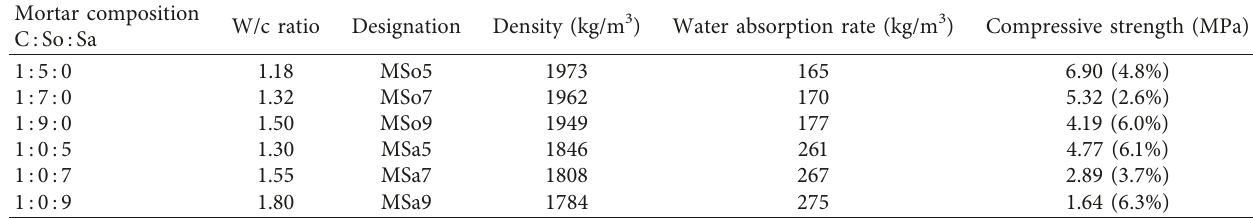
Table 5: Properties of cement-soil and cement-sand mortar cubes.